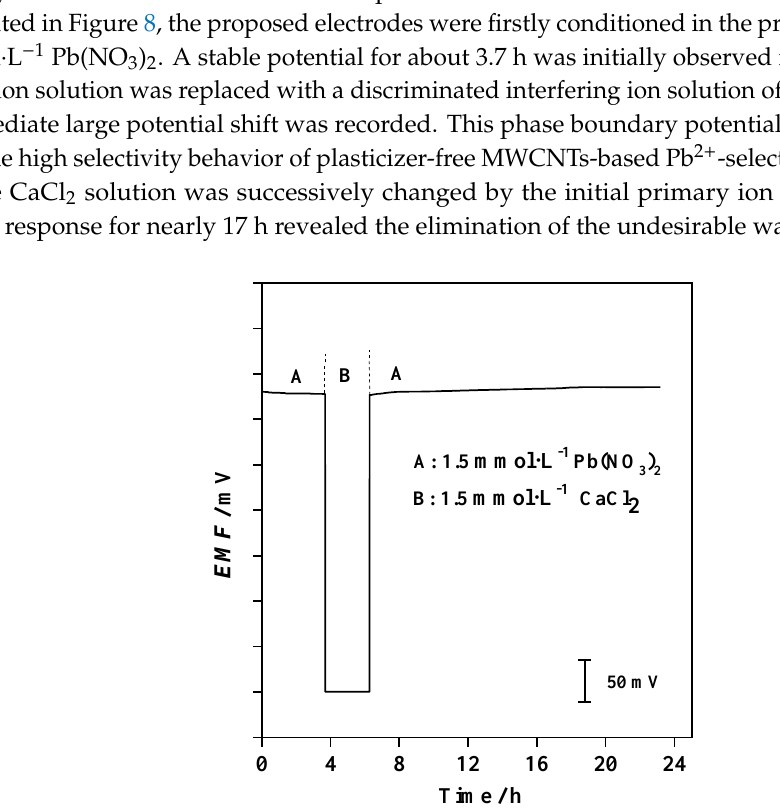
Figure 8. Potential water layer test of Au/MWCNTs/(MMA-BA)-Pb 2+ -ISEs; the measurements were switched between 1.5 mmol·L − 1 Pb(NO 3 ) 2 and 1.5 mmol·L − 1 CaCl 2 .